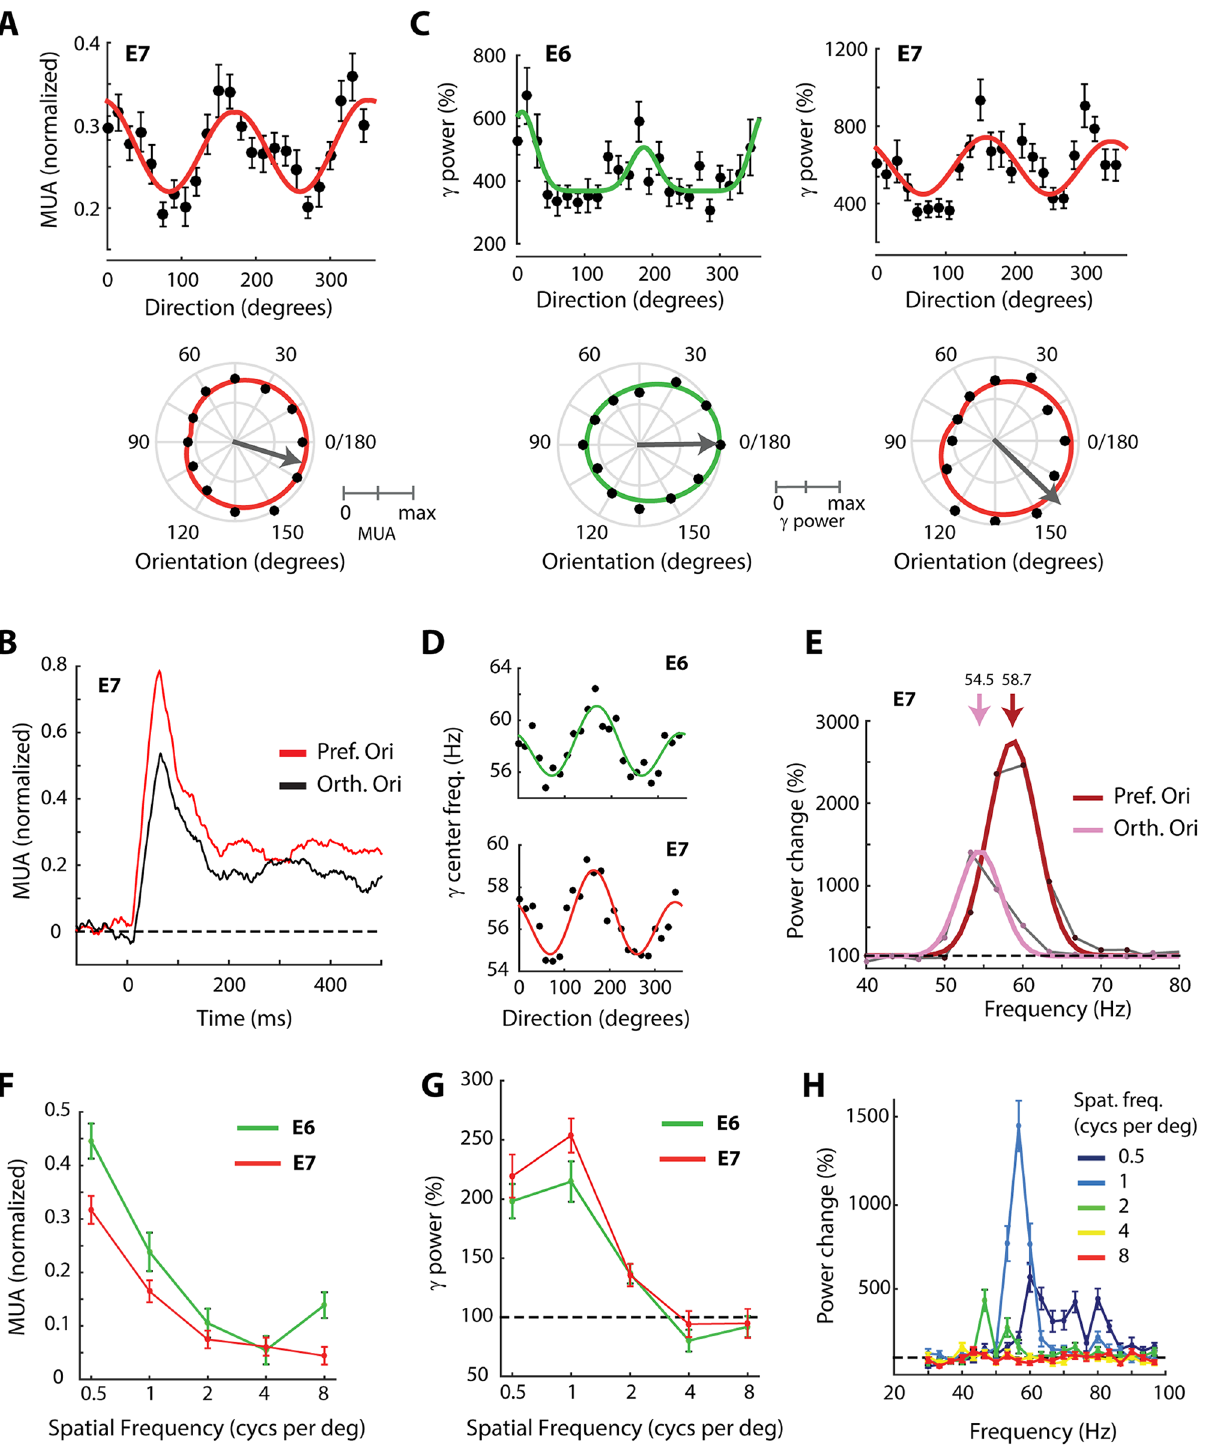
Fig 3. Orientation tuning in V2/V3. (A) Upper panel, MUA responses at electrode E7 to sine-wave gratings drifting in one of 24 directions. In this and subsequent figures, error-bars indicate +/- 1 S.E.M. The red line is the fit of a wrapped double Gaussian. The lower panel shows the same data in polar form, averaged across opposite movement directions with the same orientation and normalized to maximum response across orientations. The gray arrow is the preferred orientation (vector average). (B) Time course of MUA at E7 elicited by gratings of the preferred (averaged across 165° and 180°) and orthogonal (averaged across 75° and 90°) orientations. Orientation tuning arises very rapidly. (C) Upper panels: Gamma power (30 – 100 Hz) evoked by the 24